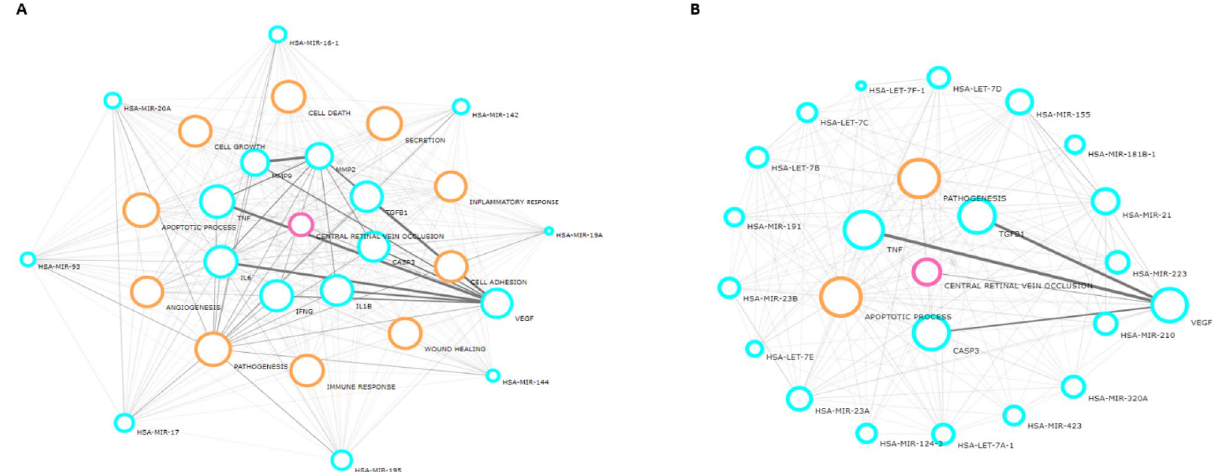
Figure 2. The relationship between miRNA genes and CRVO disease using a bioinformatics analysis. ( A ) Eight miRNAs ( hsa-mir-16-5p, hsa-mir-142-3p, hsa-mir-19a-3p, hsa-mir-144-3p, hsa-mir-195-5p, hsa-mir-17-5p, hsa-mir-93-5p, and hsa-mir-20a-5p ) were significantly downregulated in the CRVO group. Vascular endothelial growth factor (VEGF), matrix metalloproteinases-2 (MMP-2), MMP-9, tumor necrosis factor (TNF), transforming growth factor beta-1 (TGFB1), caspase-3 (CASP3), interleukin-6 (IL6), interferon gamma (IFNG), and interleukin-1-beta (IL1B) were related to the 8 miRNAs and CRVO disease. ( B ) Seventeen miRNAs ( hsa-let- 7d-5p, hsa-miR-155-5p, hsa-miR-181b-5p, hsa-miR-21-5p, hsa-miR-223-3p, hsa-miR-210-3p, hsa-miR-320a, hsa- miR-423-5p, hsa-let-7a-5p, hsa-miR-124-3p, hsa-miR-23a-3p, hsa-let-7e-5p, hsa-miR-23b-3p, hsa-miR-191-5p, hsa-let-7b-5p, hsa-let-7c-5p, and hsa-let-7f.-5p ) were significantly upregulated in CRVO patients compared to control subjects. Four factors, VEGF, TNF, TGFB1, and CASP3, were associated with the 17 miRNAs and CRVO disease. Orange circles represent the related pathway between the 8 / 17 miRNAs and CRVO